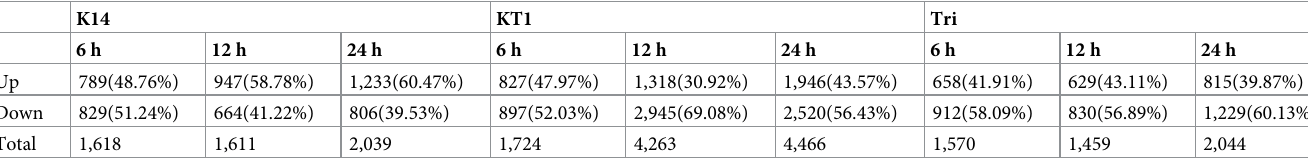
Table 2. Statistics of differentially expressed genes